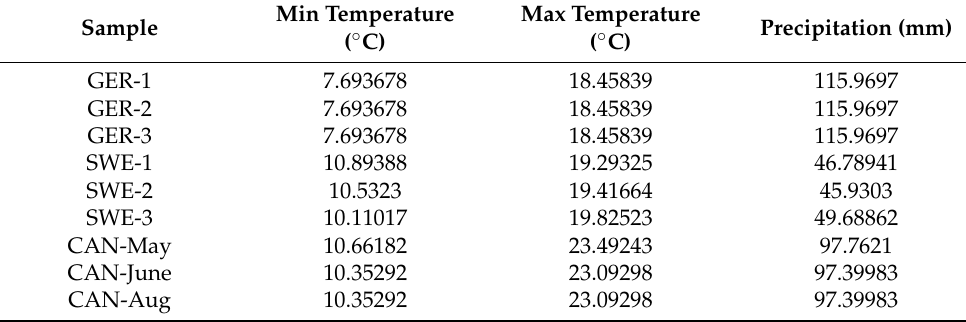
Figure 3. Average summer (May–September) temperature and precipitation data from the three sampled sites. Average minimum temperatures ( top ), maximum temperatures ( middle ), and monthly precipitation ( bottom ) data were compiled from 2010–2018 data available on WordClim. Individual samples from Canada and Germany samples were too close geographically to be distinguished, so one sample point from each country was used for figure clarity. Table 1. Average summer (May-September) weather data for the sampling sites from 2010–2018.